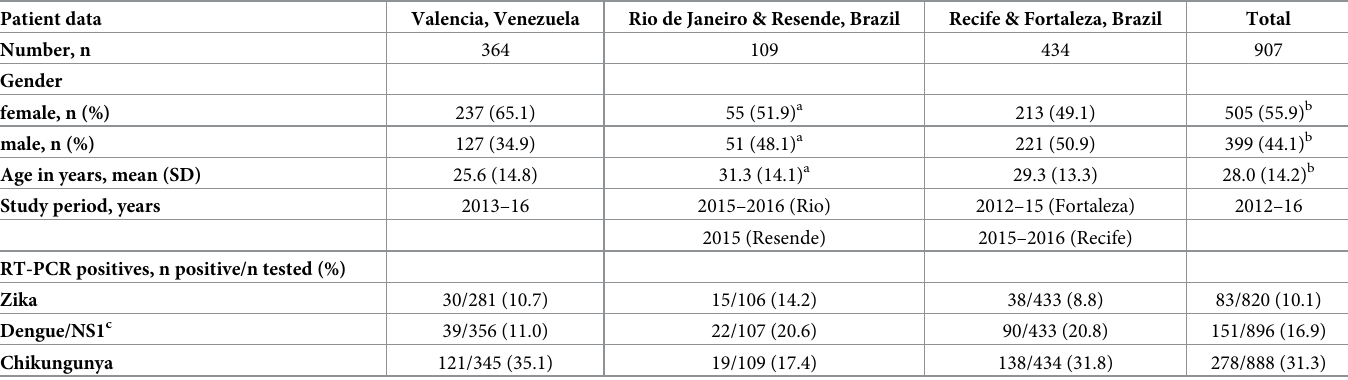
Table 1. Baseline characteristics of 907 patients from Venezuela and